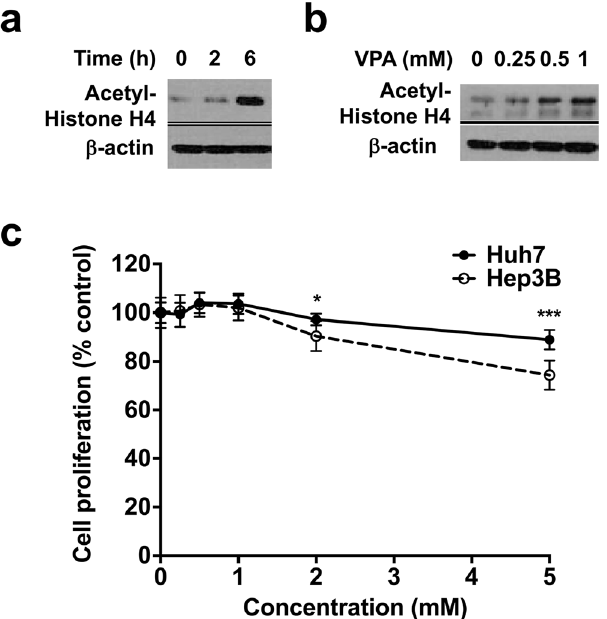
Figure 1. Valproic acid (VPA) inhibits histone deacetylase activity in human hepatocellular carcinoma cells. ( a ) Western blot analysis shows time-dependent increase of histone H4 acetylation after 1 mM VPA treatment in Hep3B cells. ( b ) VPA increased histone H4 acetylation in concentration-dependent manner. Samples were harvested 72 h after treatment of indicated concentrations of VPA in Hep3B cells. ( c ) VPA treatment leads to a modest decrease in proliferation of human hepatocarcinoma Huh7 and Hep3B cells. After 48 h of treatment of indicated concentrations of VPA, cell proliferation was determined using MTT assay. Data are mean values ± SD of 8 samples. * p < 0.05, *** p < 0.001. The cropped blots are presented and their full-length blots are included in the Supplementary Fig.